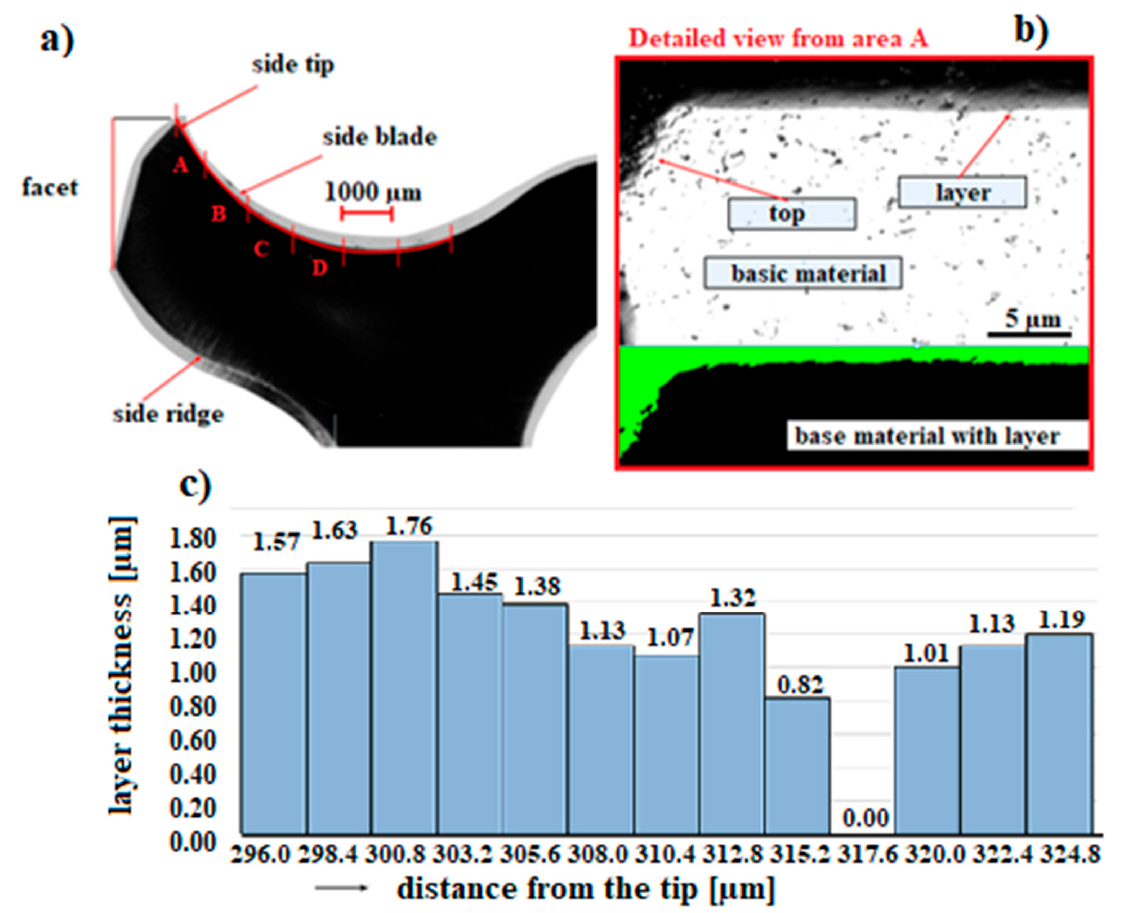
Figure 11. Display of the measured length of the coated TiAlN layer of the tool ( a ) showing the place of the coated layer ( b ) of the tool where the coating is almost completely absent ( c ).